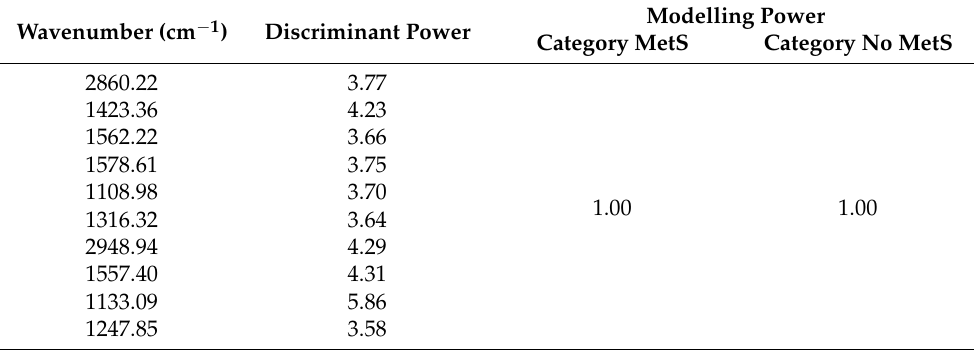
Table 6. Discriminative and modelling powers of ten selected spectra variables after SELECT-SIMCA class